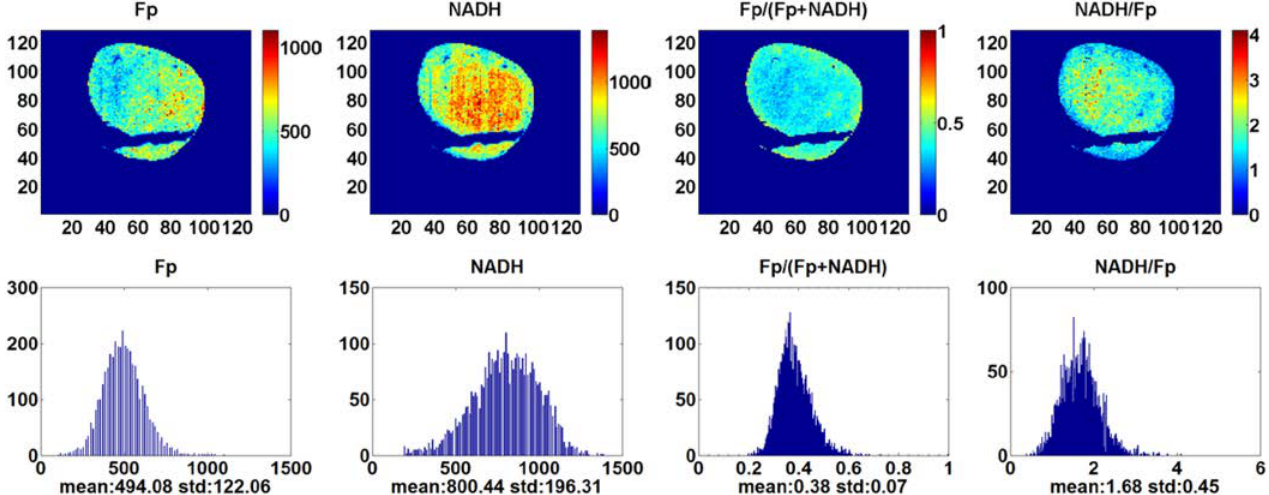
Fig. 1. Typical pseudo-color images of the redox indices (top row) and their corresponding histograms (bottom row) of a tumor in CHOP-treated group (1500 (cid:1) m under the skin). From left to right: Fp nominal concentration ( (cid:1) M), NADH nominal concentration ( (cid:1) M), Fp redox ratio (0 (cid:1) 1), and NADH/Fp. The mean value and SD are shown below the x -axes on each histogram. Image resolution: 200 (cid:1) m.